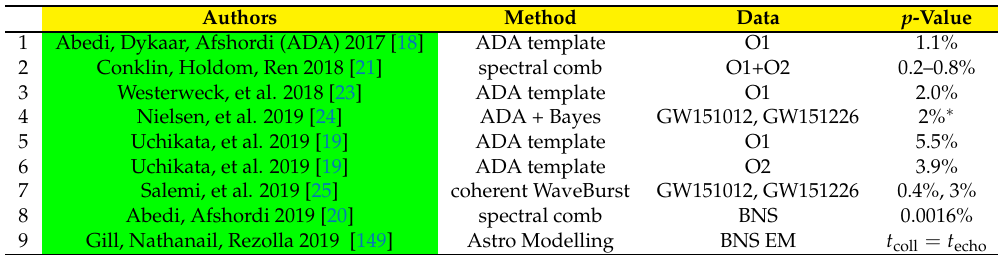
0.05) by different groups ( ∗ The p -value for Nielsen et al. [24] ≤